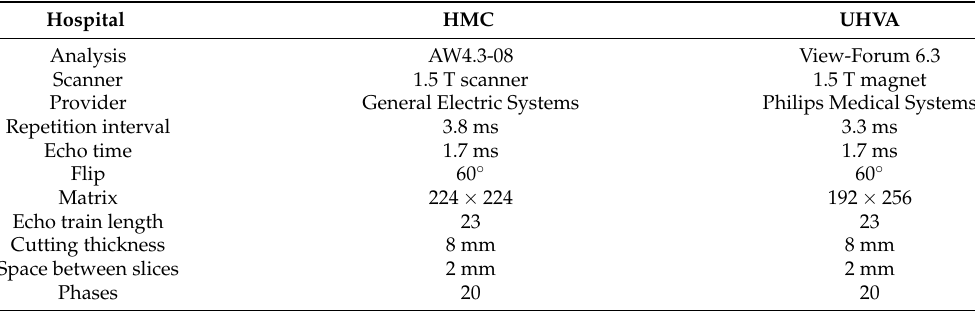
Table 1. Characteristics of the scanners. HMC, Hospital Mesa de Castillo; UHVA, University Hospital Virgen de la